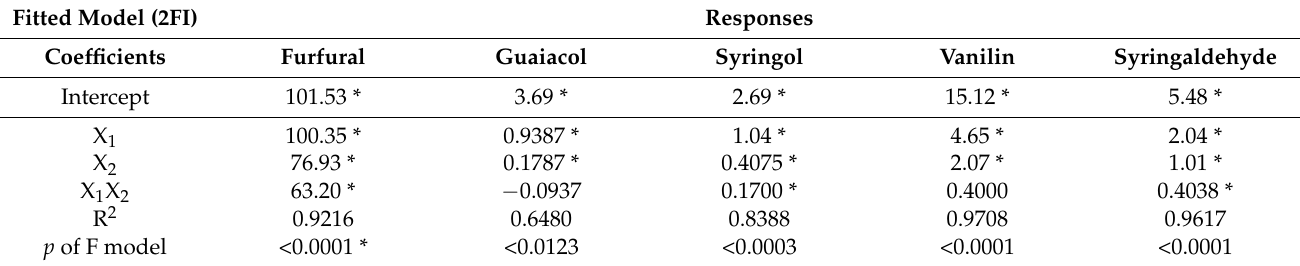
Table 5. Coefficients estimated by multiple linear regression of the physicochemical characterization of process water samples of wheat straw considering furanic and phenolic